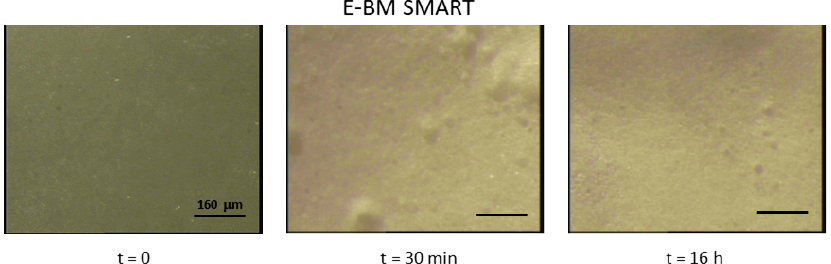
Figure 6. Stereomicroscopy images of films before and after immersion in water for 30 min and 16 h. Magnification is 40 × .